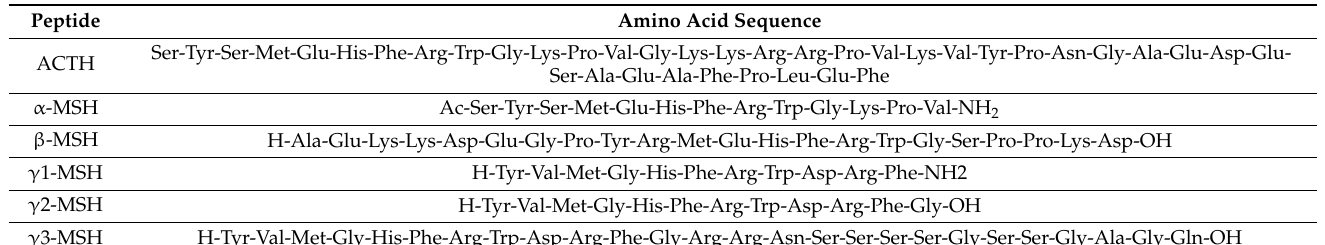
Table 1. Amino acid sequences of natural